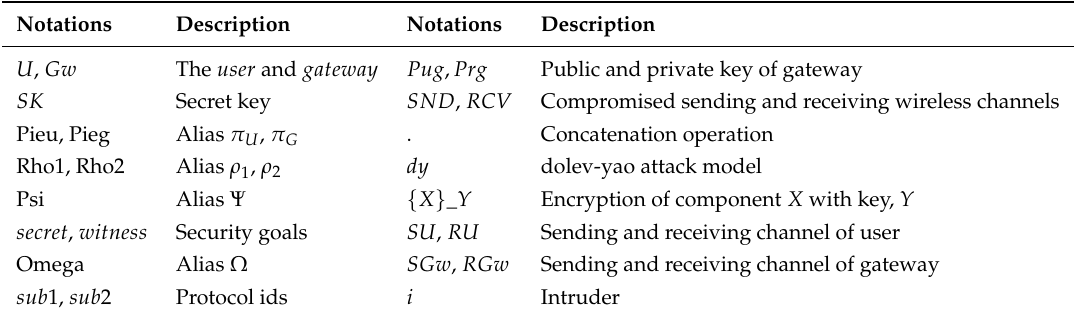
Table 2. Notations and Descriptions for the symbols used in High Level Protocol Specification Language (HLPSL) script, Automated Validation of Internet Security Protocols and Applications